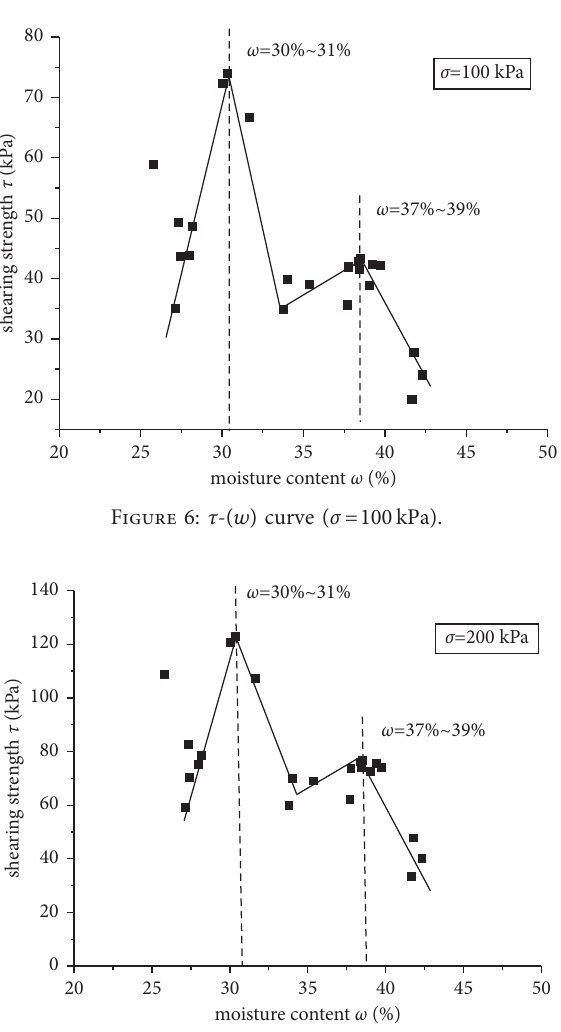
Figure 7: τ -( w ) curve ( σ �